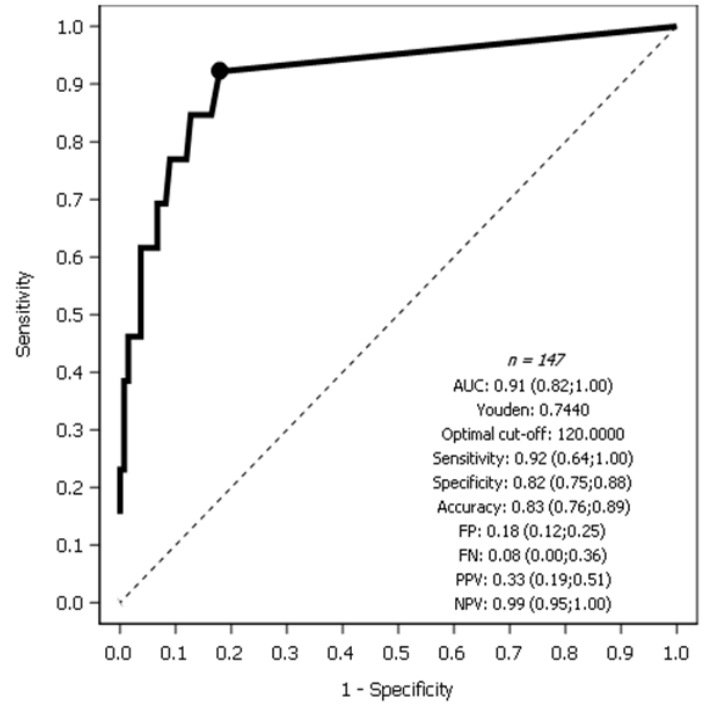
Figure 1. ROC curve showing the OSNA assay vs. pathological ultrastaging for the detection of SLN metastasis in endometrial cancer.